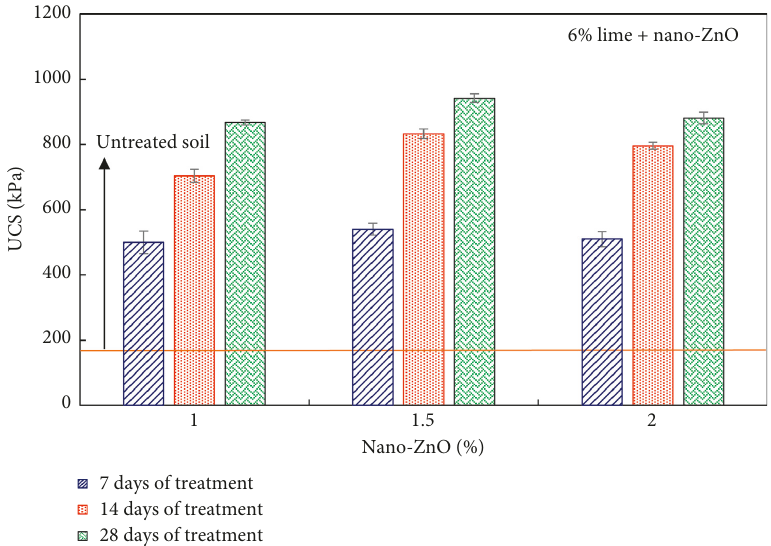
Figure 6: Effect of nano-ZnO on the UCS of lime-stabilized soil after a curing time of up to 28 days.